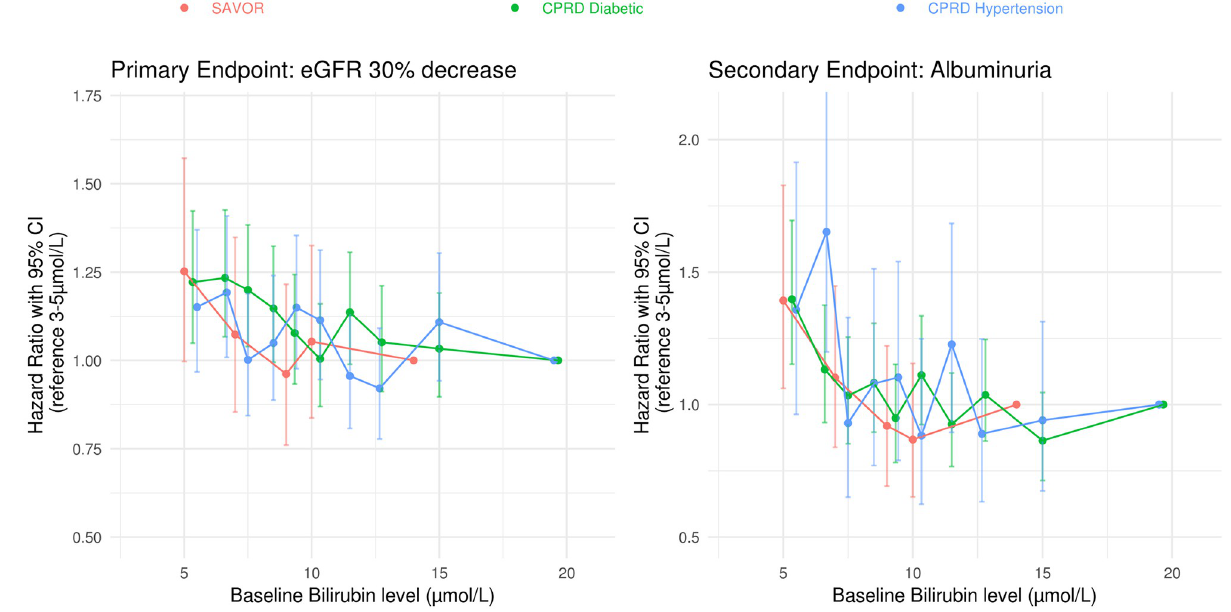
Fig 7. Relationship between the hazard ratio and serum bilirubin concentration. SAVOR cohort was subdivided into five quantiles by the baseline serum bilirubin level and the hazard ratios were calculated with the highest quantile as the reference. CPRD cohorts were subdivided into ten quantiles by the baseline serum bilirubin level and the hazard ratios were calculated with the highest quantile as the reference. Multivariable Cox proportional hazard model was used without inverse probability weighting to calculate the Hazard Ratios. The 95% confidence intervals for the outcomes were calculated based on robust